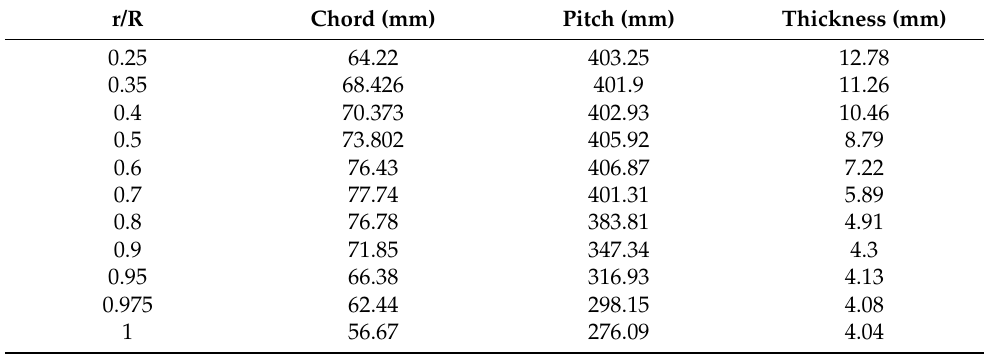
Table 2. Main radial parameters of the pump-jet